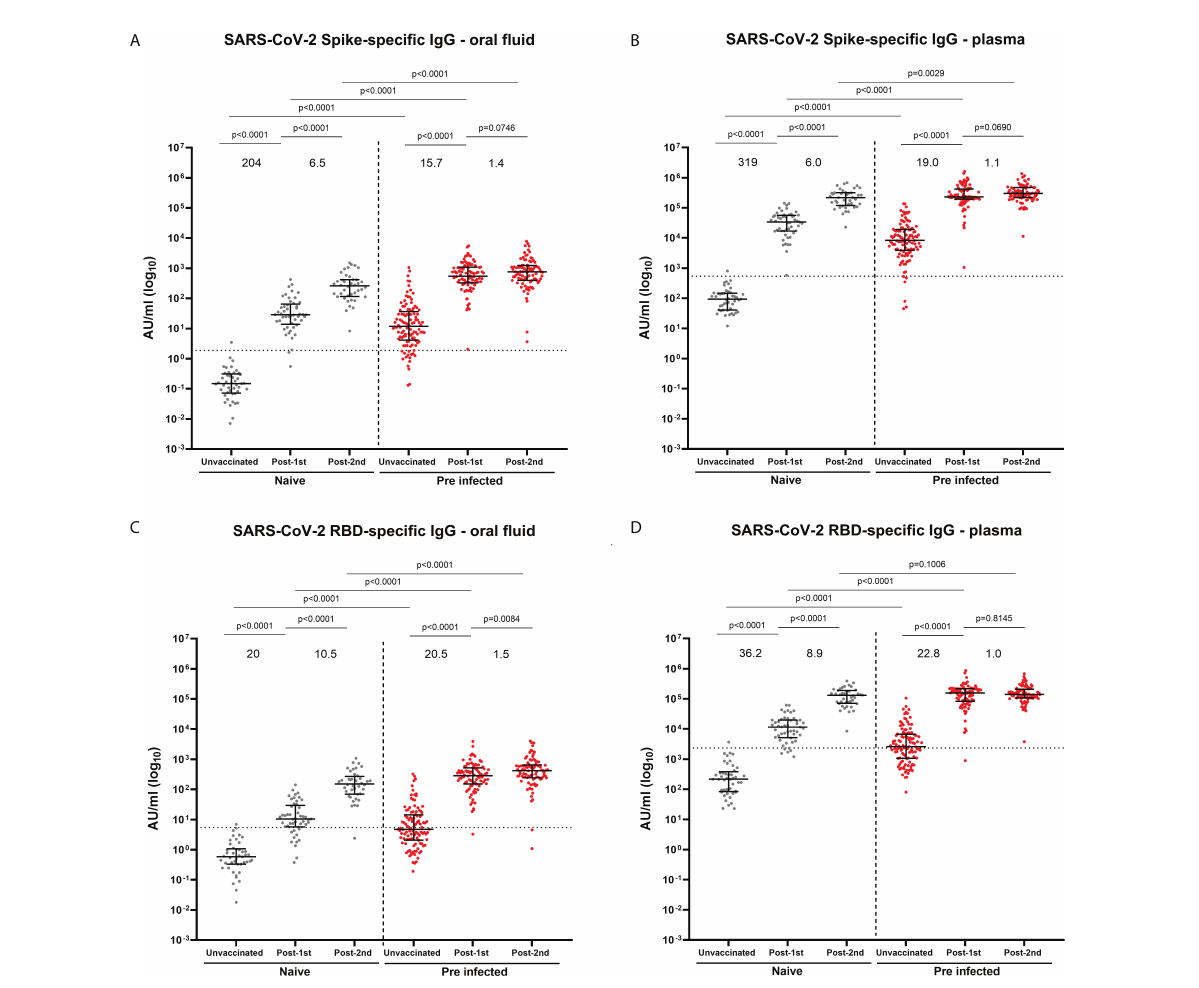
FIGURE 1 SARS-CoV-2 S- and RBD-speci fi c IgG concentrations in oral fl uid and plasma from naïve and previously-infected individuals analyzed by multiplex MSD ® assay. (A) S-speci fi c IgG in oral fl uid and (B) in plasma; (C) RBD-speci fi c IgG in oral fl uid and (D) in plasma. Data are shown in concentrations expressed in Arbitrary Units/ml (AU/ml). Mann-Whitney tests were used to determine the statistical signi fi cance between the groups of samples. Values above the columns show the fold increases in S- and RBD-speci fi c IgG levels. Dashed lines show the cut-offs based on IgG responses in 45 unvaccinated naïve samples (average concentration +